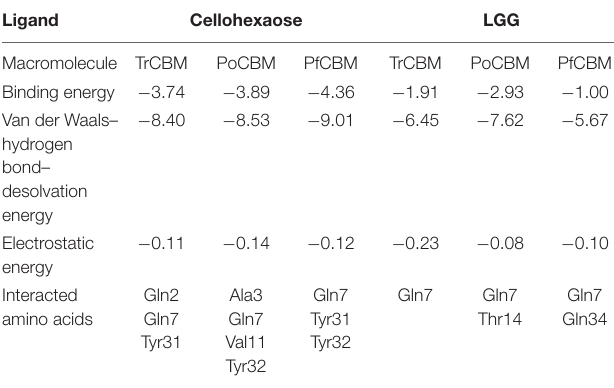
TABLE 3 | The interacted energies and amino acids at the optimal binding sites of cellohexaose and LGG to CBM1s.